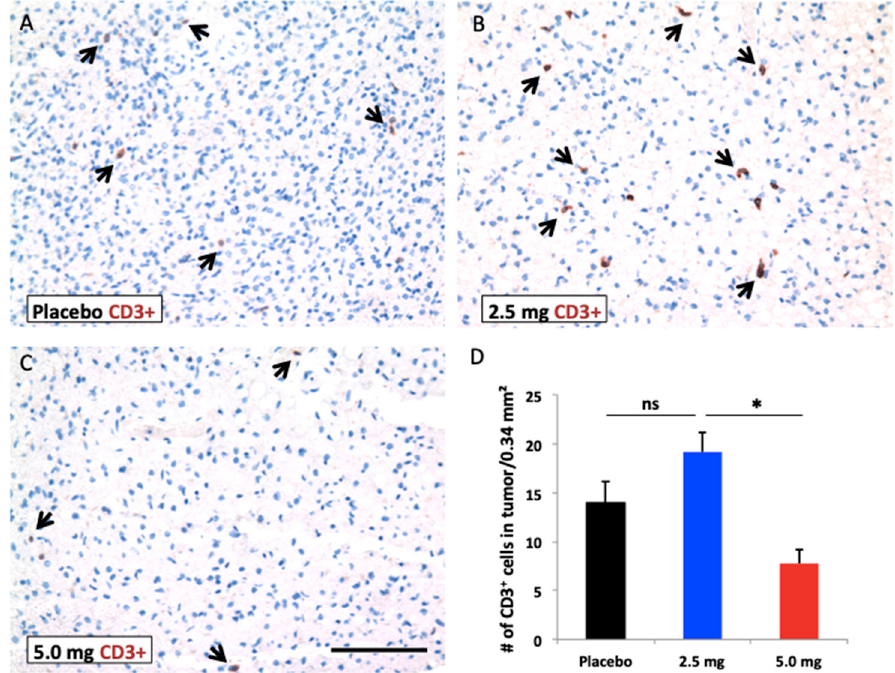
Figure 4. Immunohistochemistry with CD3 antibody. ( A – C ) representative photos after different doses of sorafenib treatment in the end of study (Arrow; CD3 + T cell). Scale bar: 100 µm. ( D ) numbers of CD3 + T cells in tumors ( n = 3), * p < 0.05 by Student’s t -test, ns; not significant.